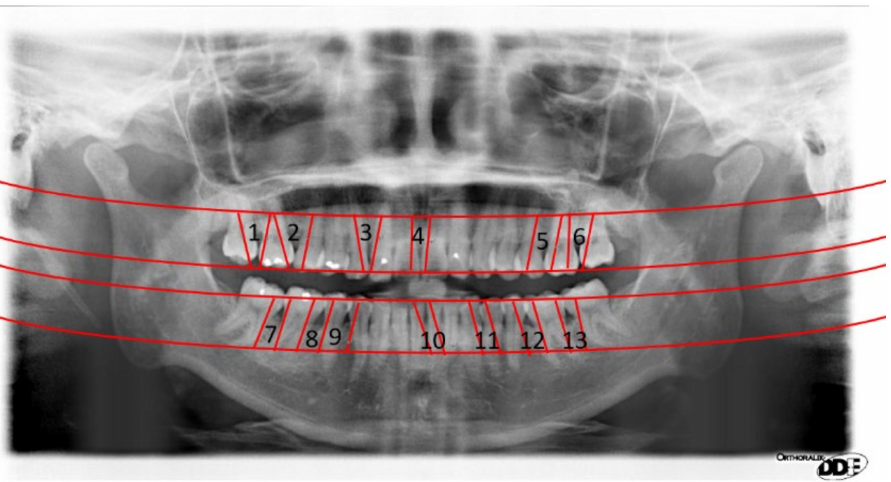
Figure 12. Positions of the gaps between the